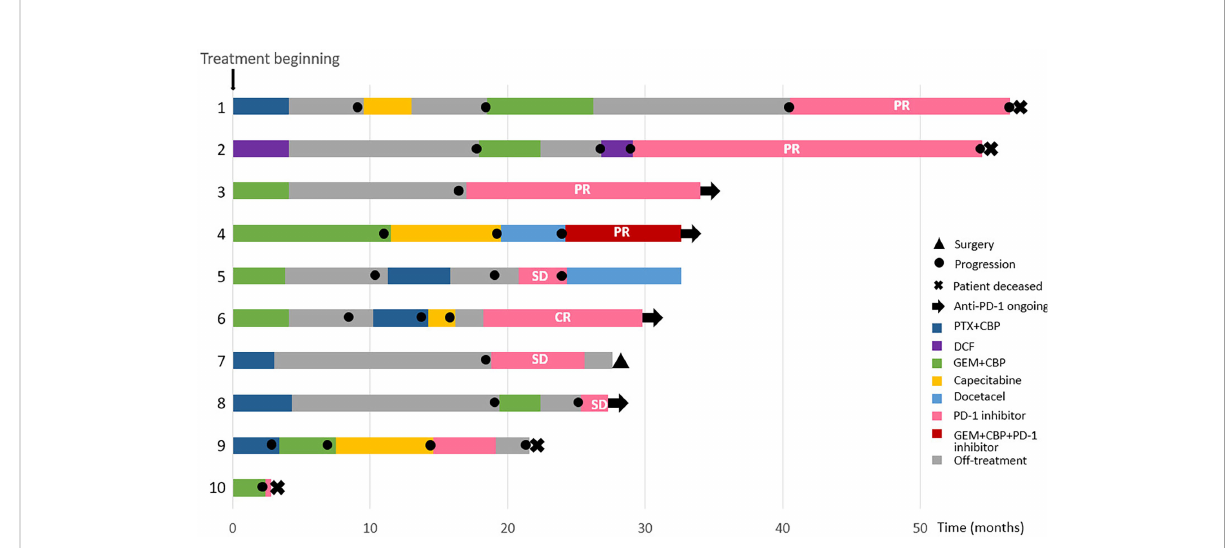
FIGURE 1 Summary of treatment reactions to chemotherapy and anti-PD-1 antibodies in the CHCSJ